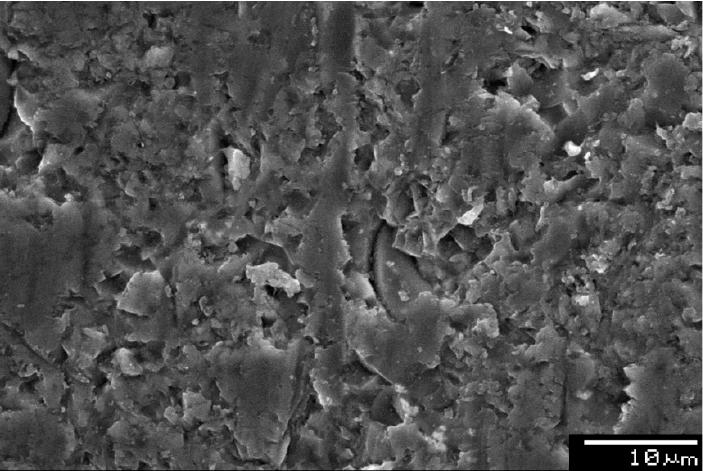
Figure 4. Control group (Group D): without surface treatment on the ceramic surface at ×2000 under SEM.